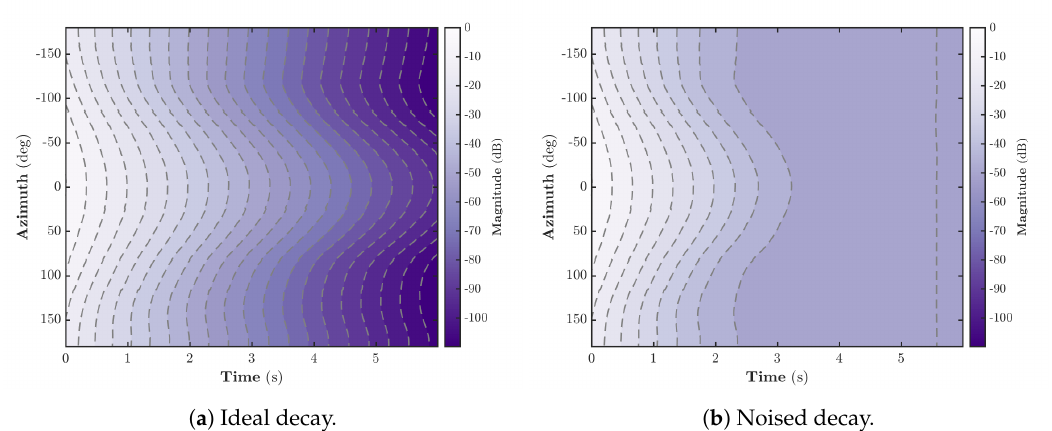
Figure 3. Reverse-integrated energy decay of the simulated anisotropic late reverberation tail, ( a ) before and ( b ) after the addition of an isotropic nondecaying noise floor. The energy decay curves (EDC) calculated for each PWD look direction are projected onto the azimuthal plane by cubic Hermite spherical interpolation (in dB scale).